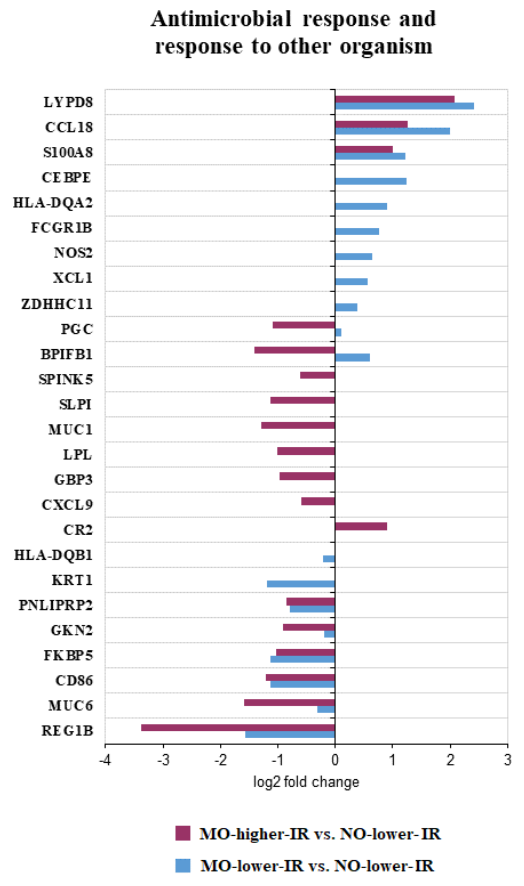
Figure 5. Representation of the Log 2 of fold change of the differentially expressed genes (DEGs) included in the overrepresented gene sets (FDR < 0.05) related to antimicrobial response and response to another organism.